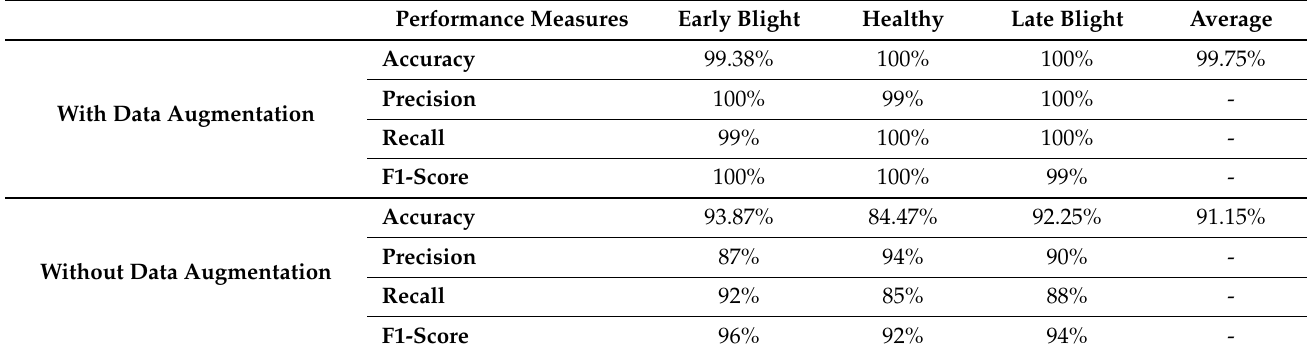
Table 7. Classification accuracies, precision, recall and F1-Score of the proposed PDDCNN model on the PLD